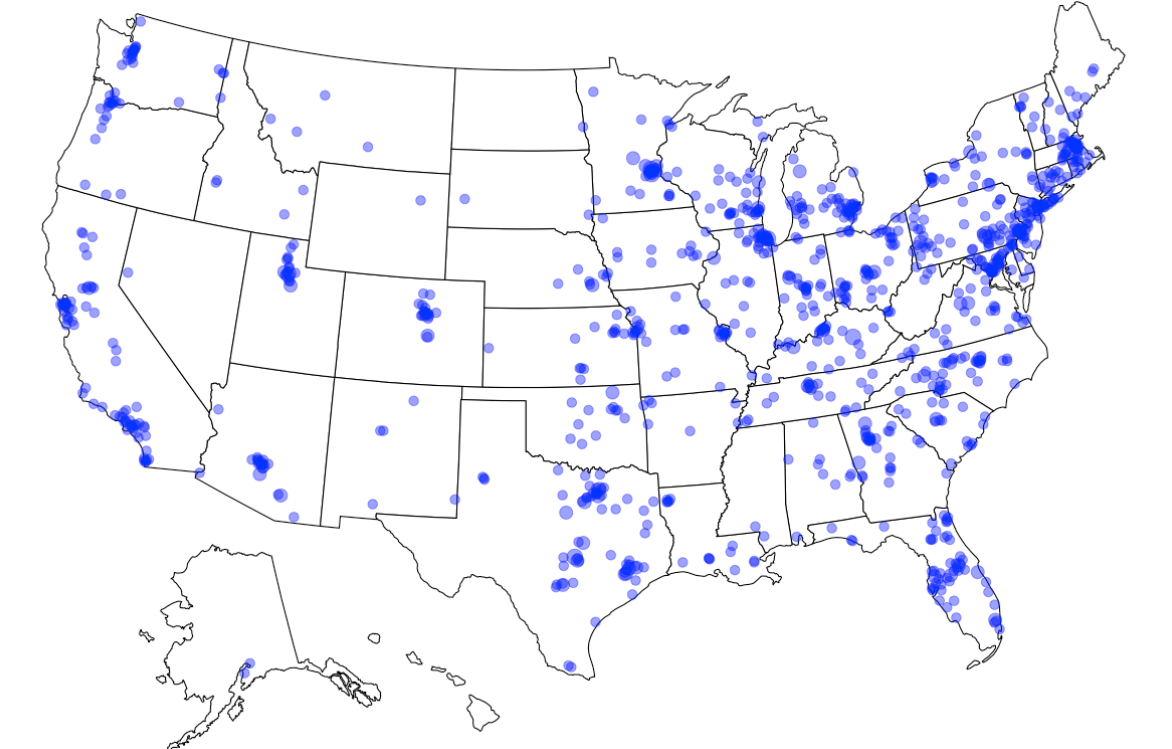
Figure 2. Geographic distribution of study participants. Point size is scaled by the number of participants per zip